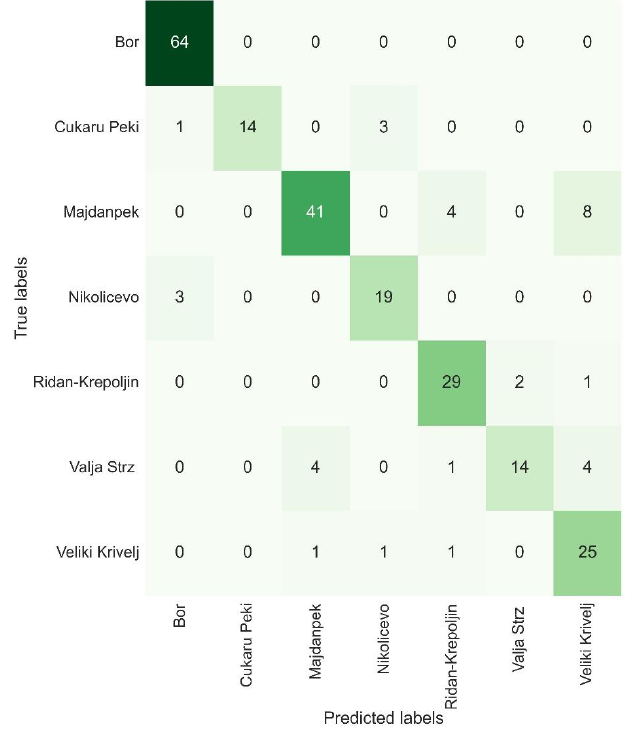
Figure 18. Confusion matrix for classifying rocks from different deposits. We used trace element data and Eu anomaly as input variables for the decision tree and random forest classifiers. Adding log fO2, calculated after [59], did not change the accuracy of the prediction.